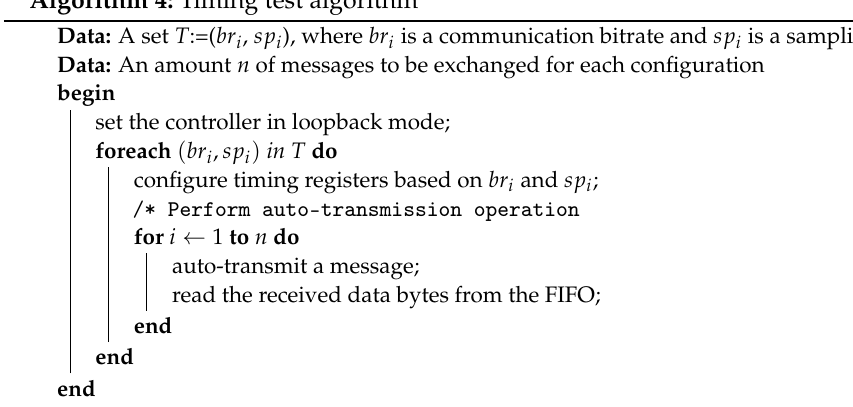
Algorithm 4: Timing test